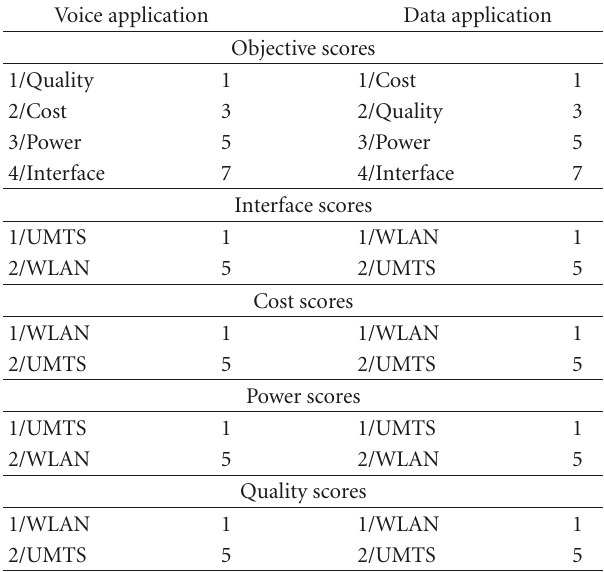
Table 2: Criteria and network scoring. Table 3: Objective and network pairwise comparison matrix in AHP